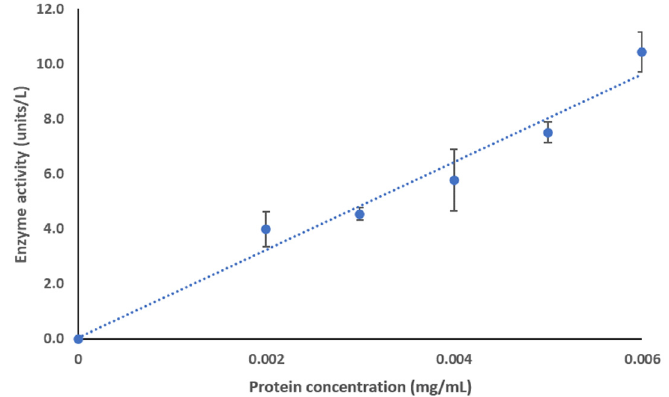
Figure 15. ClpK ATPase activity. ATPase activity was determined by incubating protein at varying concentrations (0–0.006 mg/mL) in reaction buffer containing 40 mM Tris, 80 mM NaCl, 8 mM MgAc 2 , 1 mM EDTA, and 4 mM ATP (pH 7.5) for 30 min. The release of phosphate ions was determined at 620 nm. The absorbance values were then used to calculate enzyme activity. Each data point is an average of three independent measurements, and the error bars represent standard deviation. Equation: y = 1600.4x + 0.0361, R 2 : 0.9677.